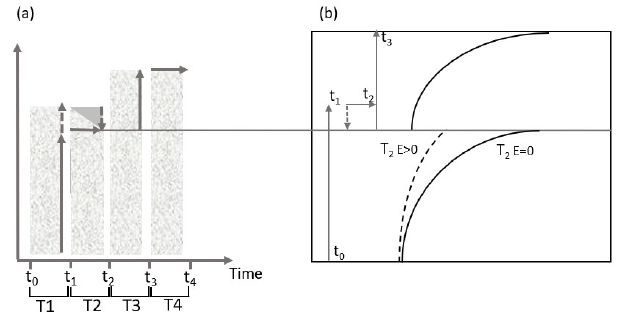
Figure 2. Illustration of the effect of discontinuous aggradation on the depth profile of cosmogenic radionuclide concentrations. (a) The sedimentary sequence consists of two aggradation phases (T1 and T3) that are interrupted by erosion or stability during T2. (b) The in situ-produced CRN profile shows two superimposed clas- sical CRN depth profiles. The lower part of the profile represents two depth profiles: the dashed line illustrates the CRN depth profile when T2 undergoes erosion ( E > 0), and the solid line represents the CRN depth profile when T2 corresponds to a stability phase ( E =